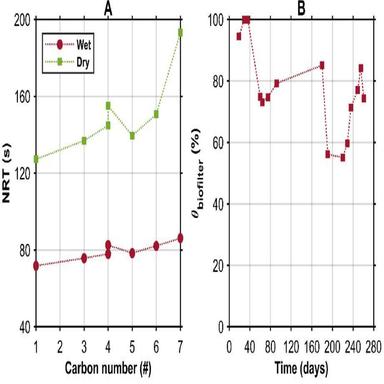
(A) Net Residence Time (NRT) of different alkanes (C1 to C7) in the biofilter for dry and wet conditions. (B) Evolution of the biofilter porosity (qbiofilter) over time.